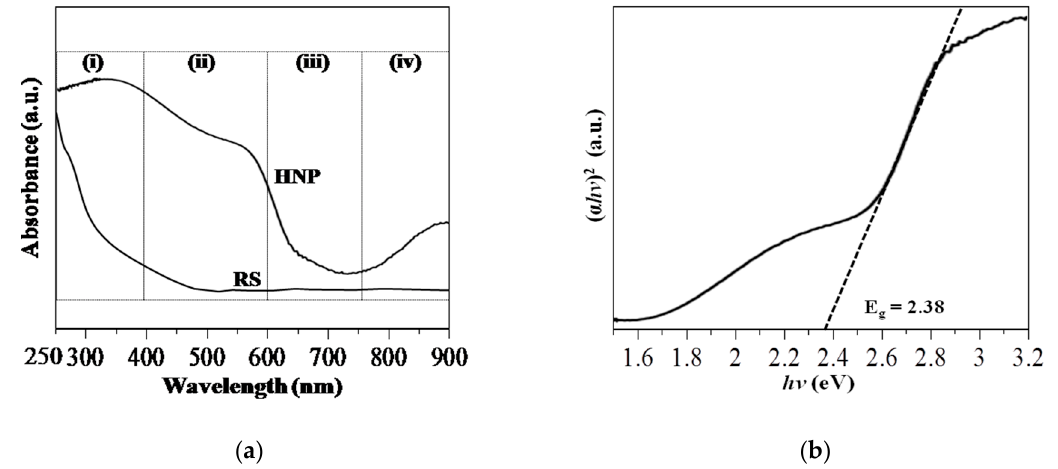
Figure 7. Optical analysis for ( a ) UV-Vis diffuse reflectance spectroscopy (DR UV-Vis) and ( b ) Tauc plot of the Sp-HNP.